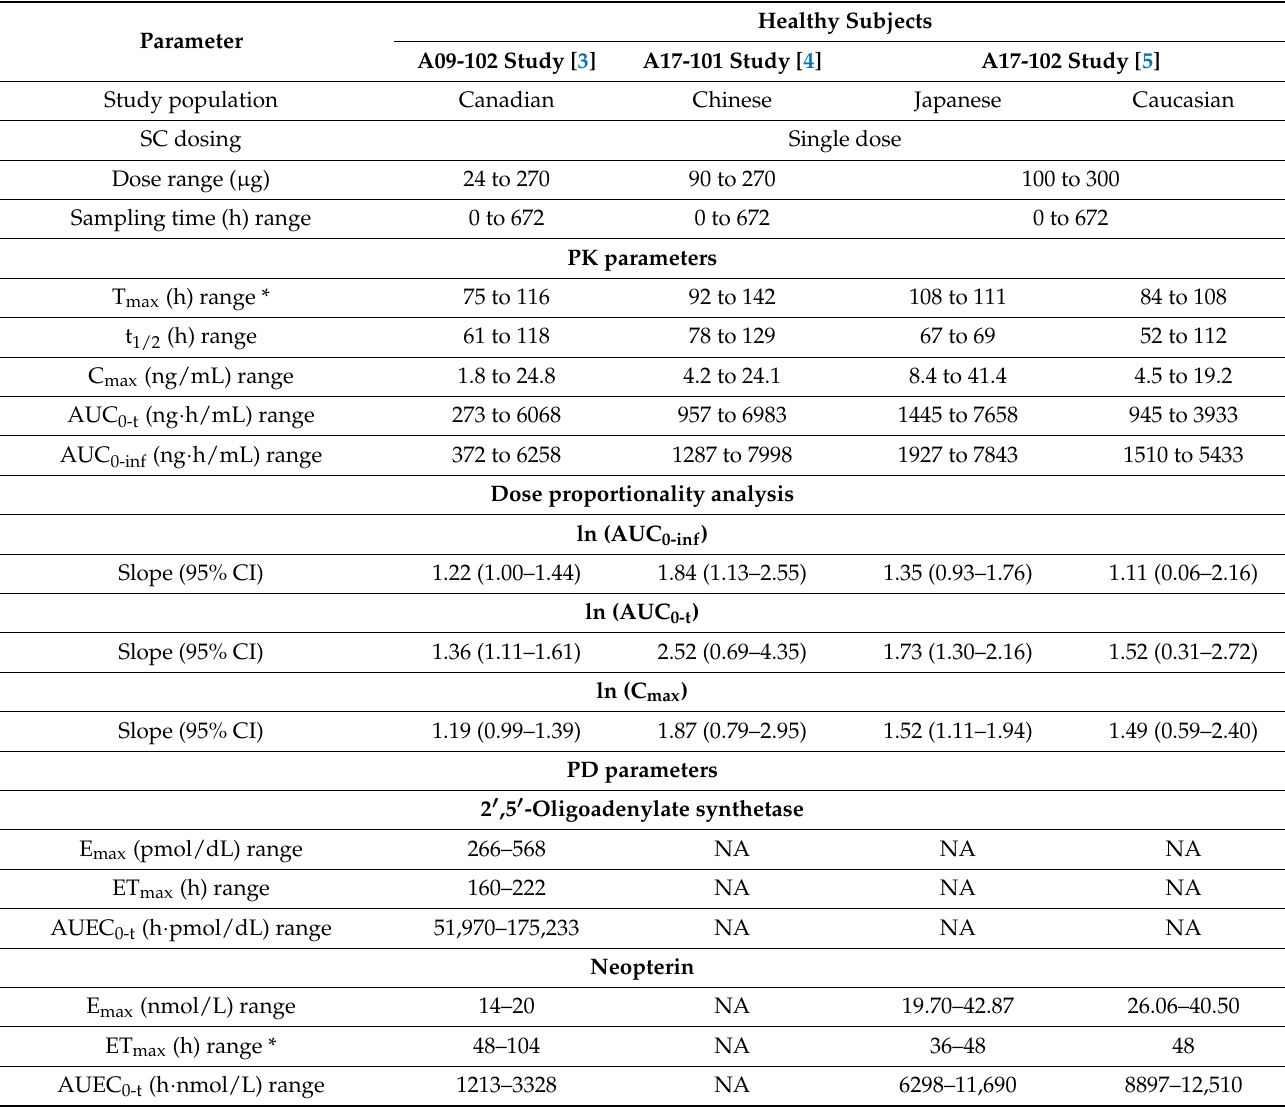
Table 1. PK/PD parameters of ropeginterferon alfa-2b in clinical studies of healthy